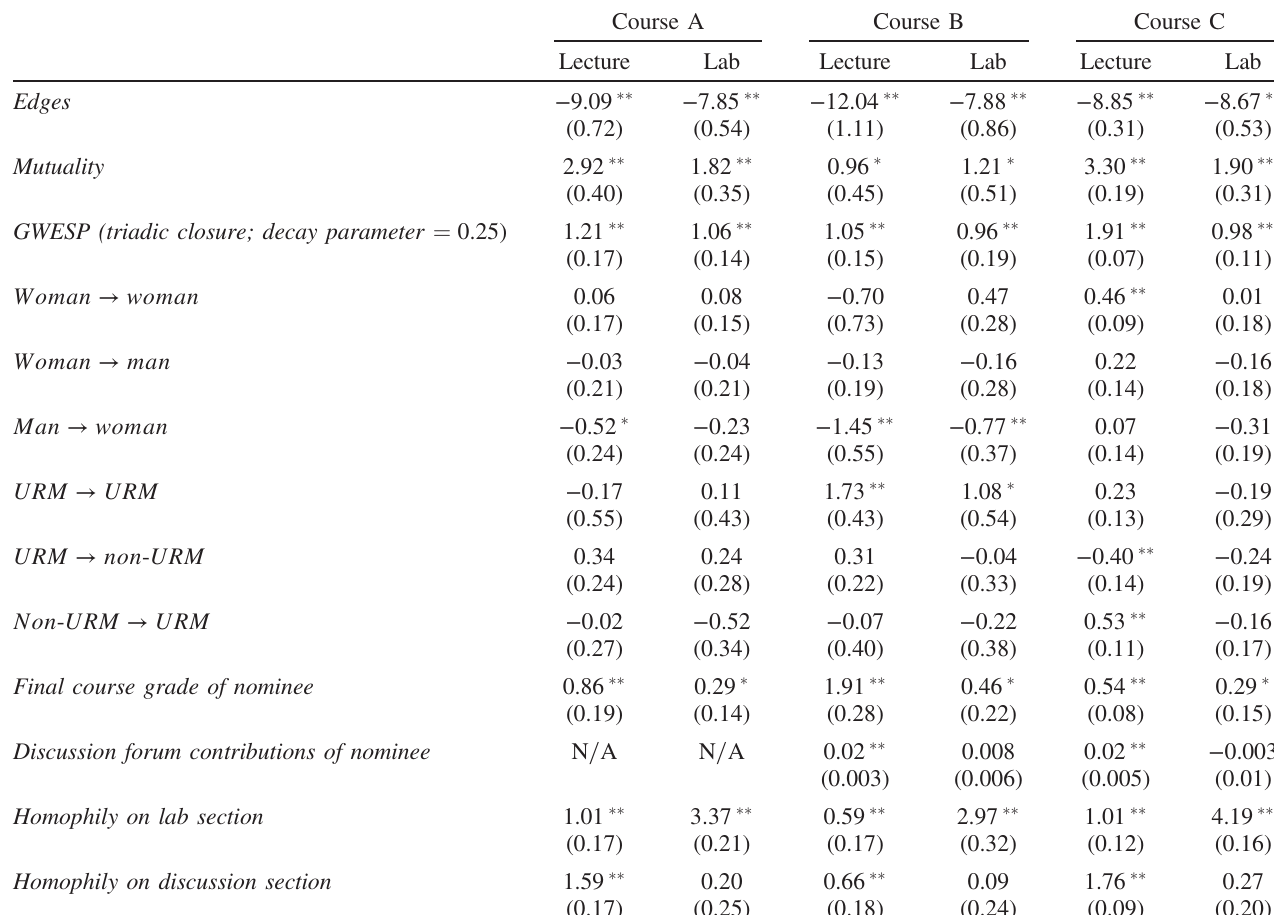
TABLE IV. Exponential random graph model results. We fit models with all possible permutations of the gender and race or ethnicity variables serving as the base terms, but here we show results using nominations between majority demographic groups as the base terms ( man → man for gender and non - URM → non - URM for race or ethnicity). Standard errors of the coefficient estimates are in parentheses. Asterisks indicate statistical significance ( (cid:3) p < 0 . 05 ; (cid:3)(cid:3) p < 0 . 01